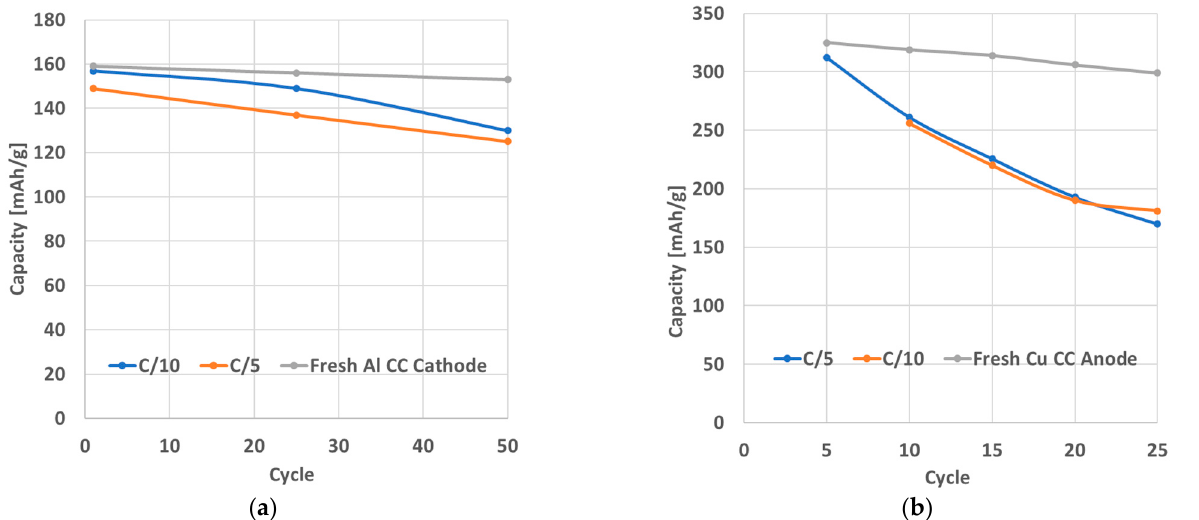
Figure 13. The capacity retention of ( a ) cathode half-cells over 50 cycles and ( b ) anode half-cells over 25 cycles compared to cathodes and anodes made from fresh Al and Cu CC.